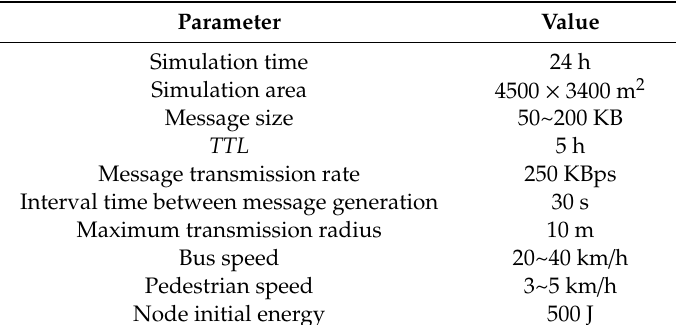
Table 2. simulation parameters’